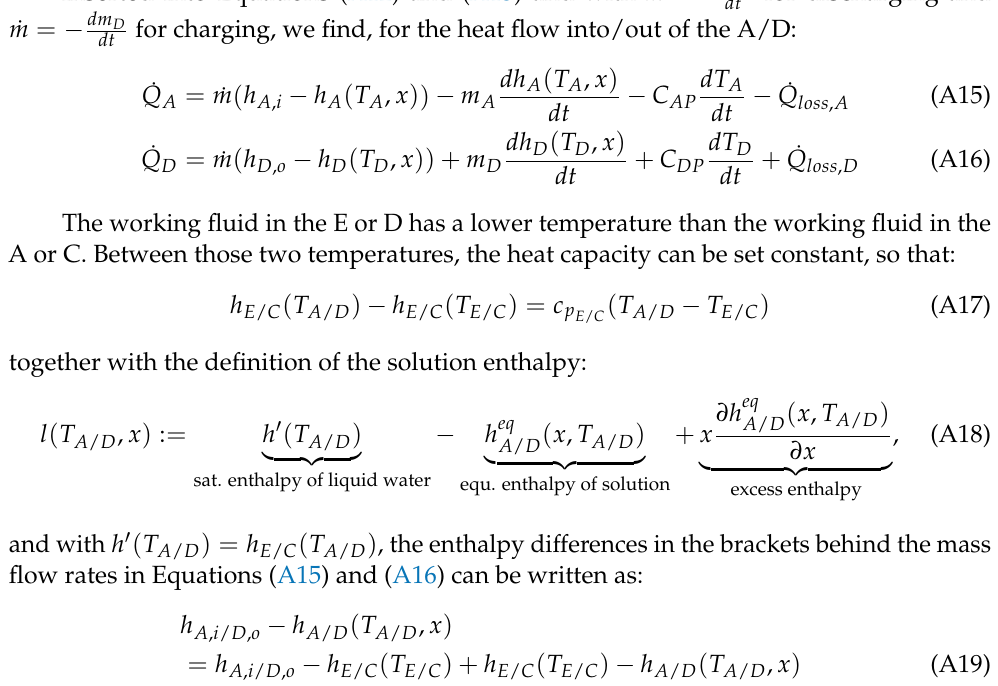
for discharging dt